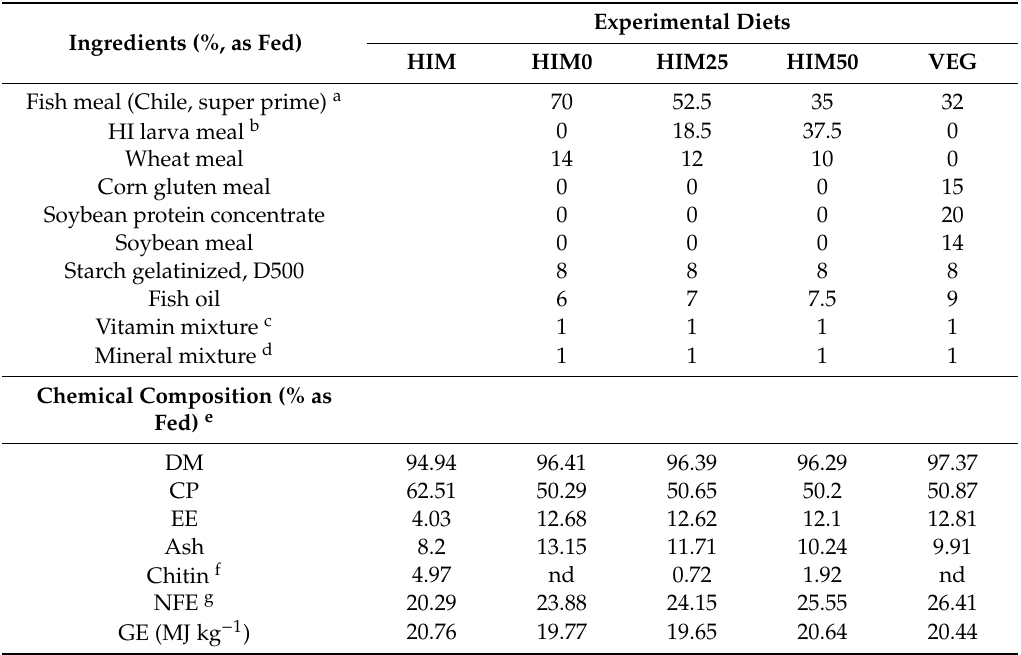
Table 1. Ingredients and proximate composition of H. illucens larva meal and experimental diets (modified from Caimi et al.